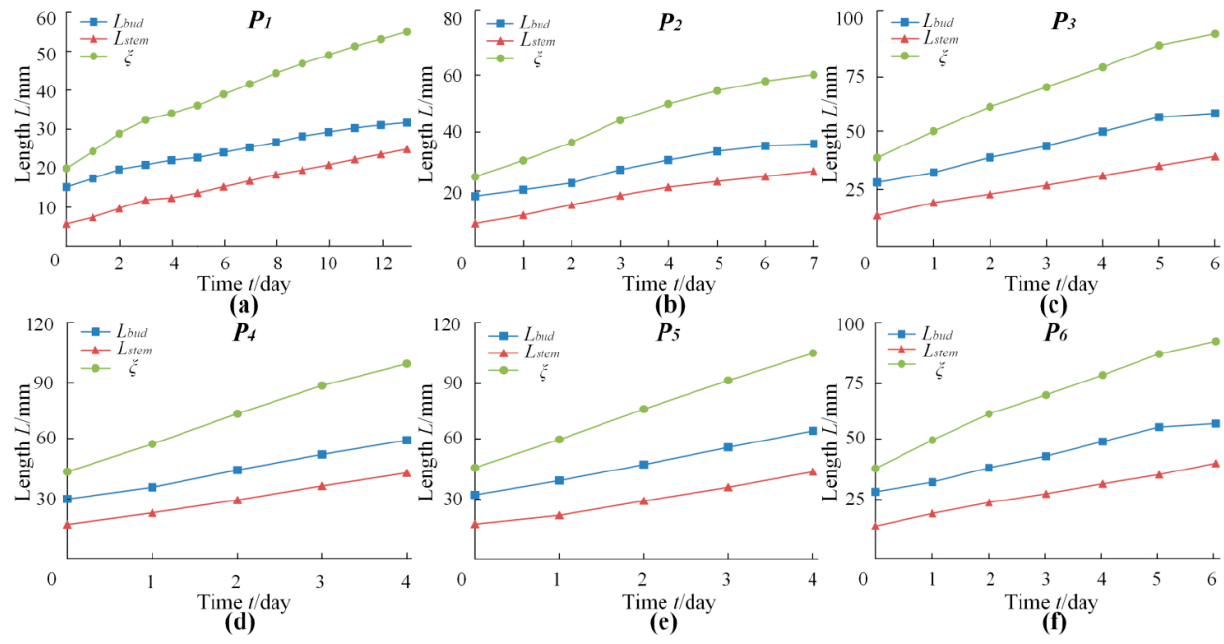
Figure 7. Variation rules for L bud , L stem , and ξ with growth time for P 1 , P 2 , P 3 , P 4 , P 5 and P 6 ( a – f